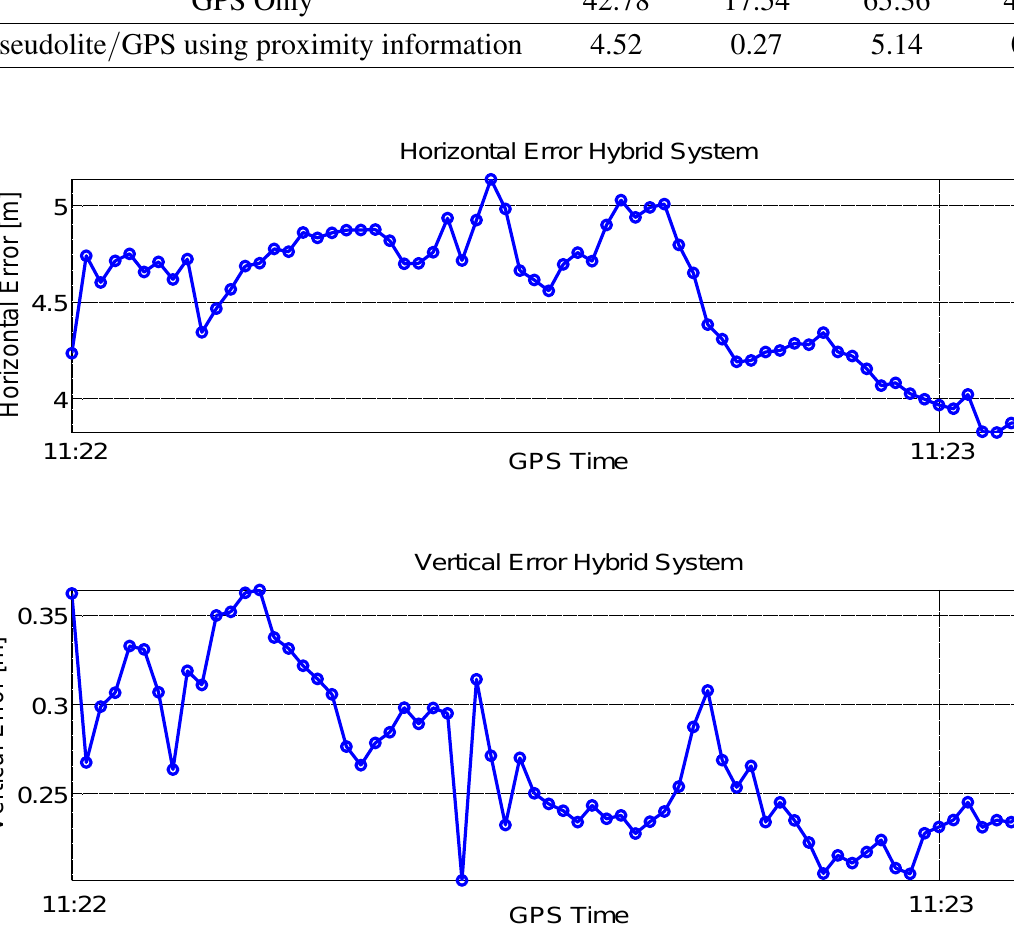
Figure 8. Horizontal and vertical errors of the hybrid solution with proximity